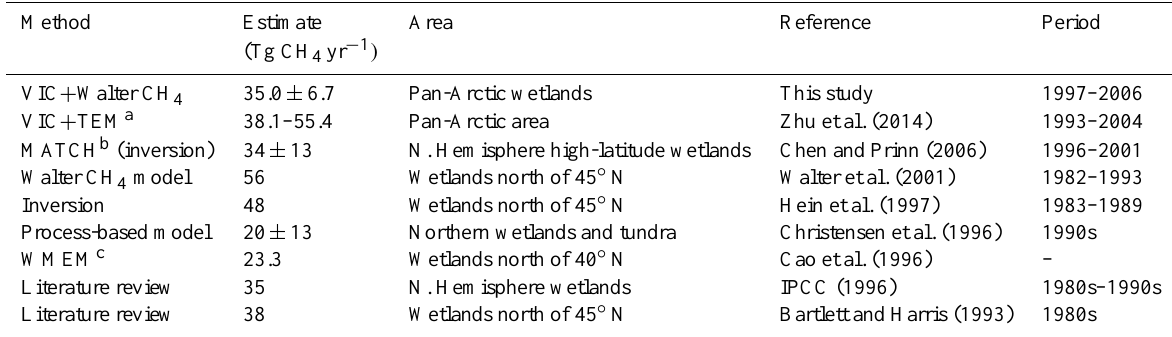
Table 3. Estimates of total CH 4 emissions over the study domain.